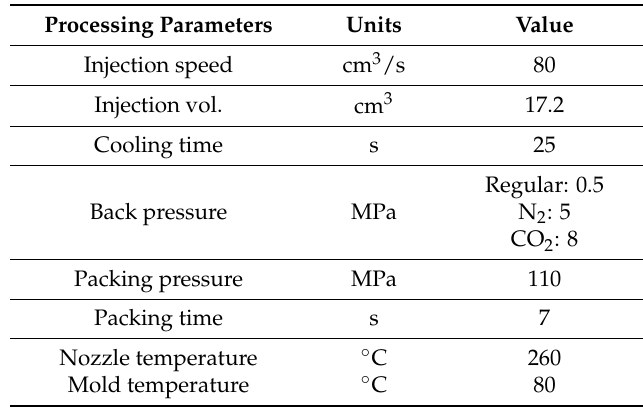
Table 2. Processing parameters used in injection molding.